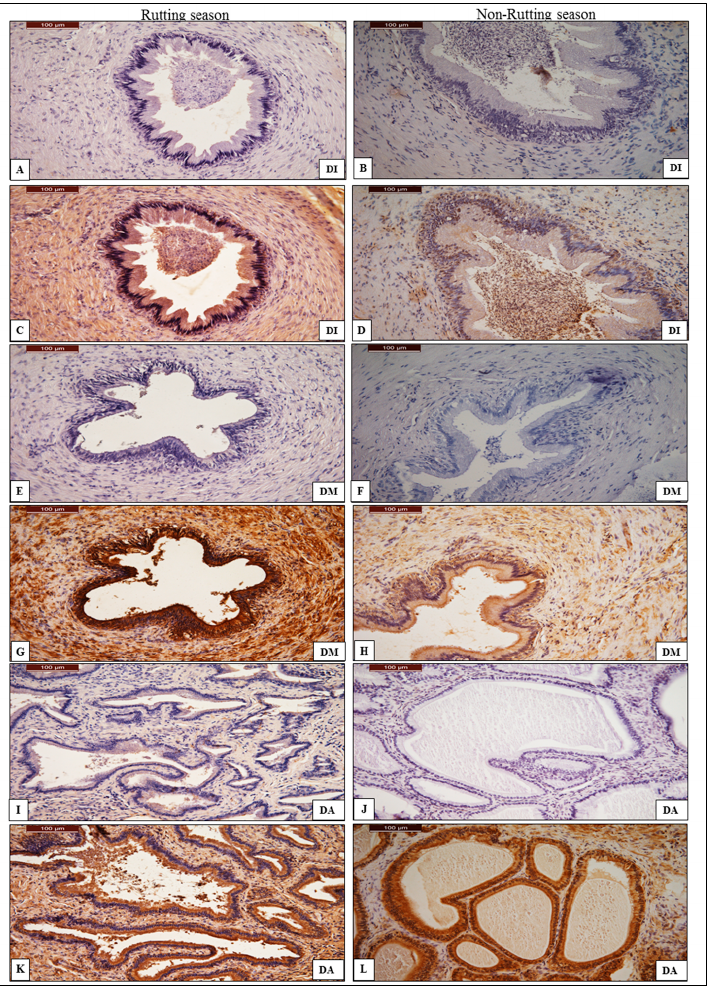
Figure 4. Chromogenic immunohistochemistry of anti-AQP-7 antibody in the initial part (DI), middle part (DM) and ampullary part of ductus deferens (DA). ( A , E , I ): negative control of anti-AQP-7 antibody in DI, DM and DA during rutting season; ( C , G , K ): positive reaction of AQP-7 in DI, DM and DA of ductus deferens during rutting season shows very intense positivity of AQP-7. ( B , F , J ): negative control of AQP-7 in DI, DM and DA of ductus deferens during non-rutting season;